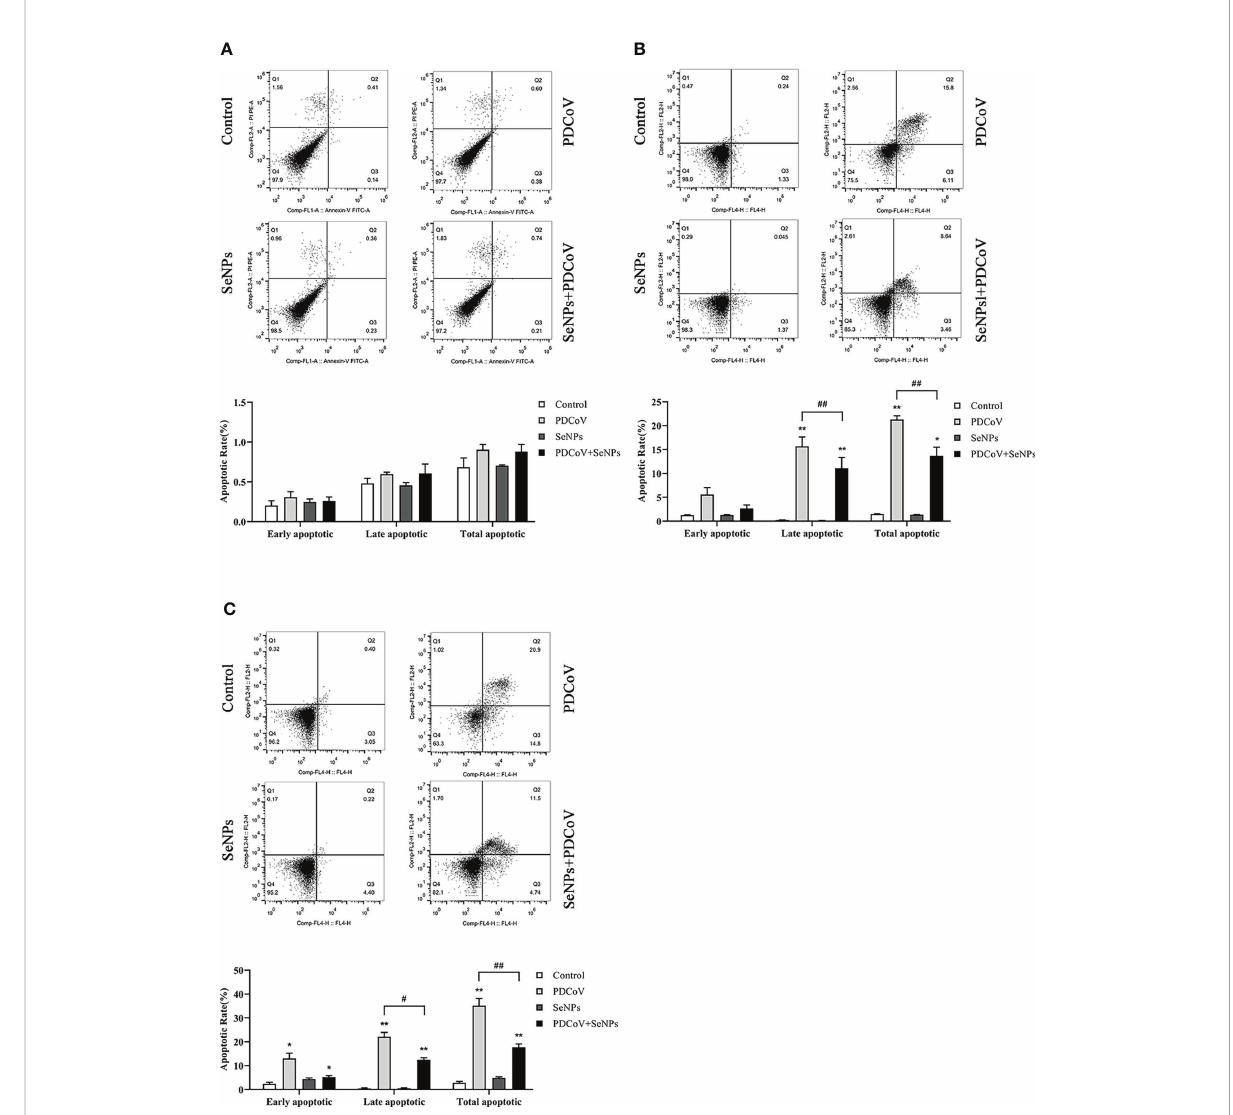
FIGURE 8 Effect of SeNPs on apoptosis induced by PDCoV. (A – C) are the fl ow quadrant diagram and apoptosis rate change diagram of each treatment group at 6, 24, and 48 h, respectively. * indicates that the difference is signi fi cant compared with the control group ( P < 0.05), ** indicates that the difference is extremely signi fi cant compared with the control group ( P < 0.01); # indicates that there is a signi fi cant difference between the PDCoV group and the PDCoV+SeNPs group ( P < 0.05), ## indicates that there is a signi fi cant difference between the PDCoV group and the PDCoV+SeNPs group ( P < 0.01), and there is no signi fi cant difference ( P > 0.05) in the unlabeled expression,